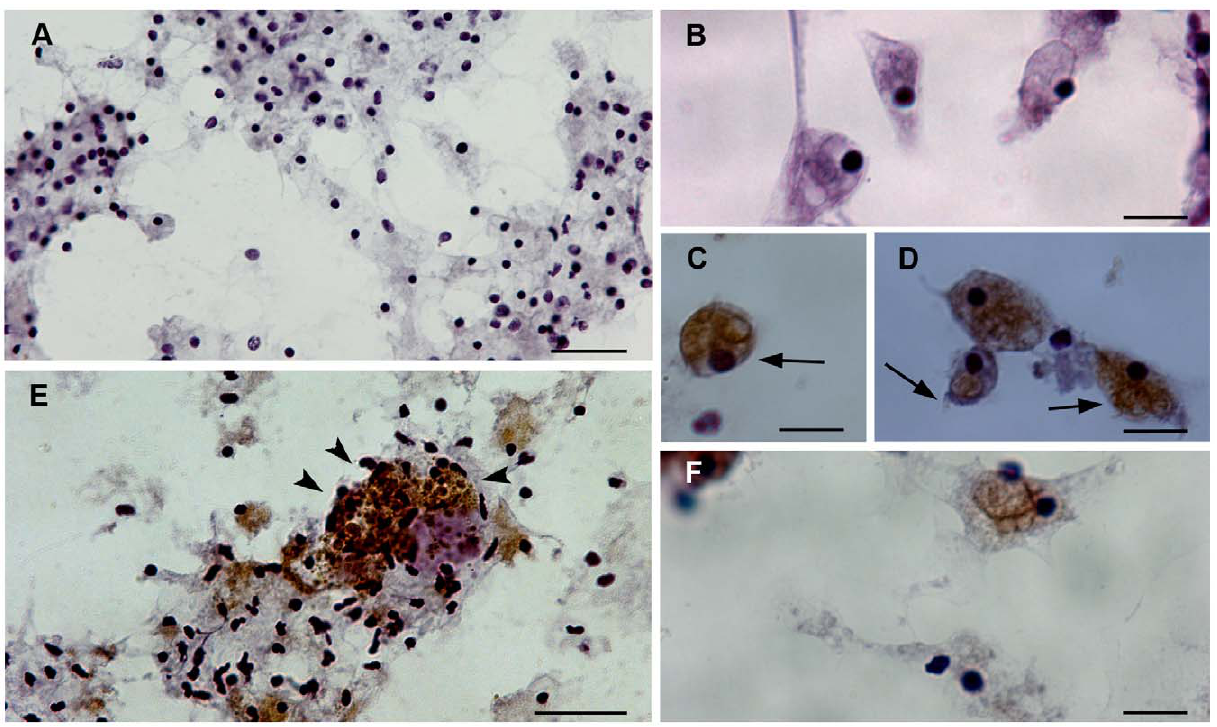
Figure 2. Myt C expression in mussel hemocytes at the protein level. Control hemocytes without anti-Myticin sera but with secondary antibody are presented in figures A and B. A positive reaction is detected by the deposition of brown deposits following DAB treatment (C, D, E and F). Degranulation of hemocytes is indicated with arrowheads. The presence of myticin on vacuoles (at the surface or inside) is indicated with arrows. Scale bars: 50 m m in A and E and 10 m m in B, C, D and F. (Figure 1). The strongest expression of Myt C was detected in the plicae base of the gills (Figure S1). Because mussels are filter-feeding animals that can inhabit polluted locations and even feed on bacteria [17,18], the gills are the first tissue to come in contact with putative pathogens; the high presence of Myt C-expressing hemocytes could suggest a role for this AMP in a fast immune response.